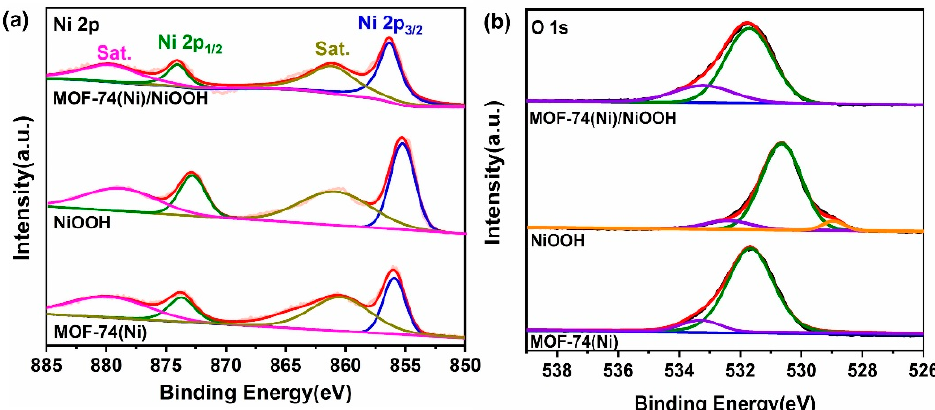
Figure 3. High-resolution XPS spectra of Ni2p ( a ) and O1s ( b ) of NiOOH, MOF-74(Ni), and MOF-74(Ni)/NiOOH.